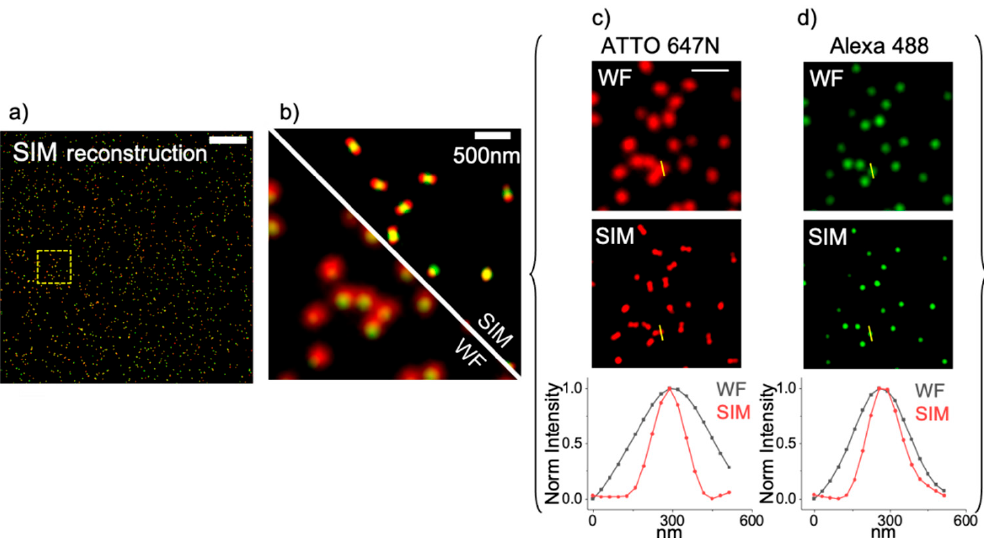
Figure 2. Evaluation of the optical resolution achieved by SIM imaging. ( a ) 1024 × 1024 pixel SIM reconstructed Image, scale bar 5 µm. ( b ) 128 × 128 pixel ROI from image ( a ). Shown are Widefield acquisition, bottom left, and SIM acquisition top right, scalebar 500 nm. ( c ) Analysis on the red channel: shown are the Widefield image (top), the SIM reconstruction (middle) and the intensity profiles corresponding to the yellow lines (bottom). The values of resolution extracted from these profiles are r WFred = 350 nm; r SIMred = 137 nm. ( d ) Analysis on the green channel: shown are the Widefield image (top), the SIM reconstruction (middle) and the intensity profiles corresponding to the yellow lines (bottom). The values of resolution extracted from these profiles are r WFgreen = 260 nm; r SIMgreen = 150